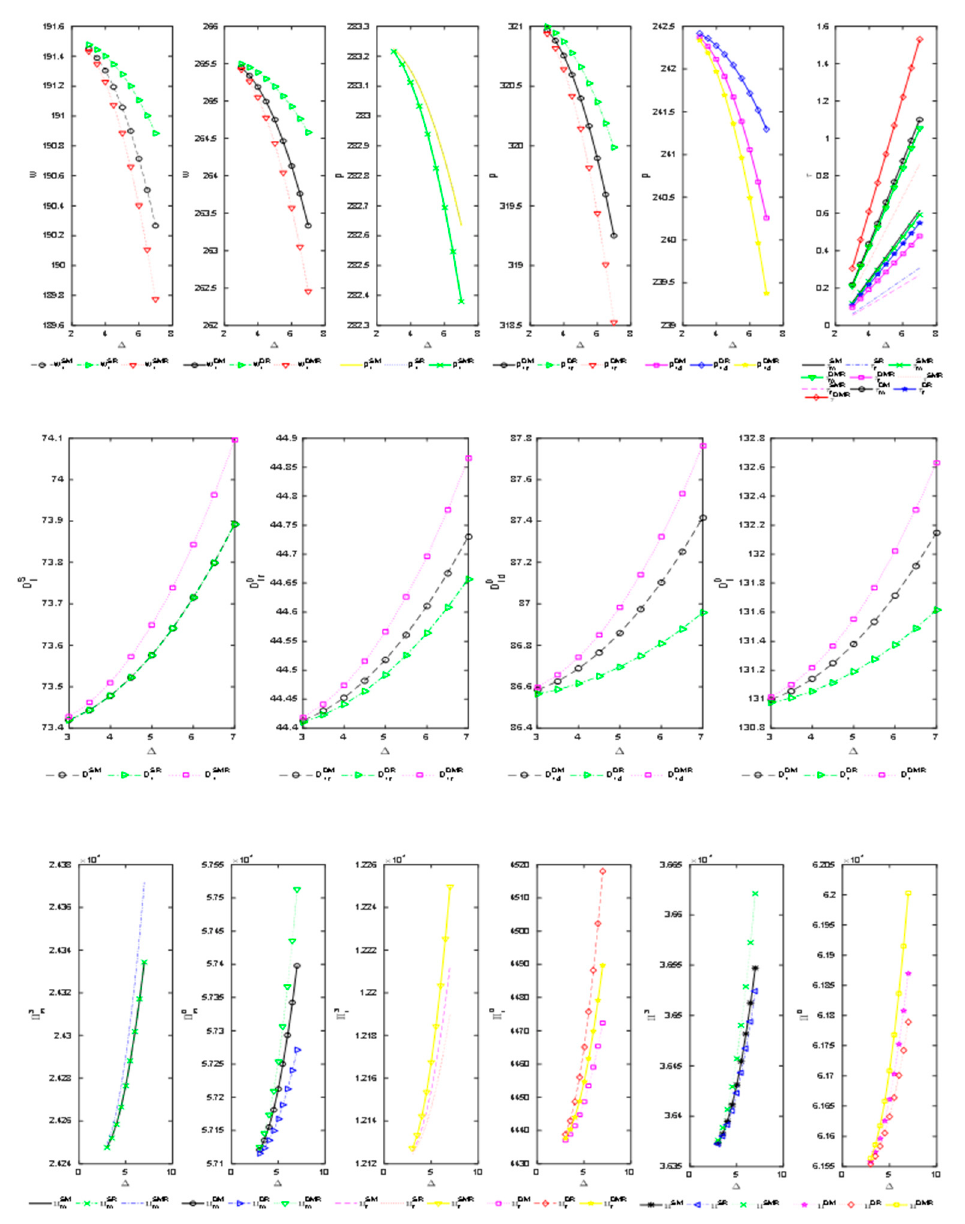
Figure 8. Changes of the wholesale price/selling price/collecting rate/market demand/profit with ∆